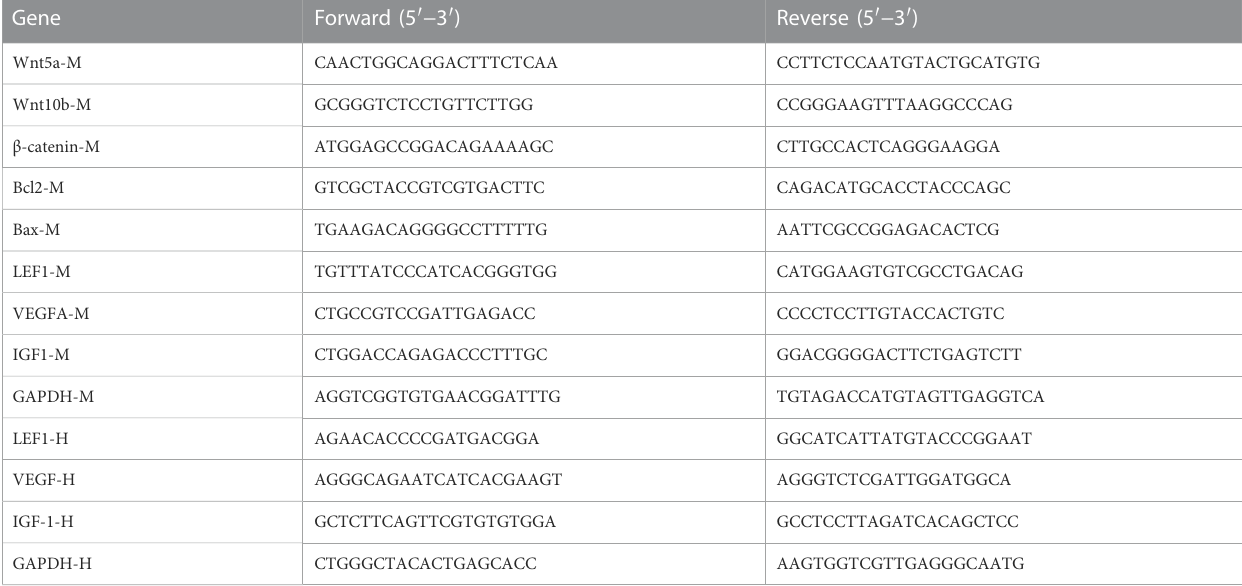
TABLE 1 The primer